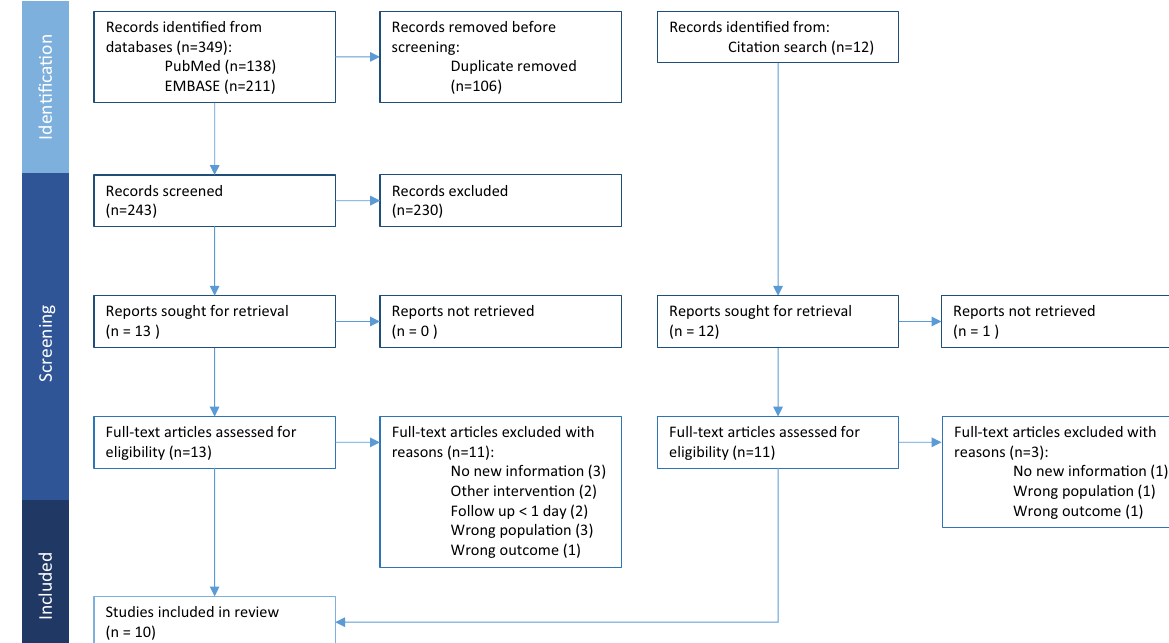
Figure 2. PRISMA Flow Chart. Preferred Reporting Items for Systematic Review and Meta-Analysis (PRISMA) flow diagram showing the identification, screening, eligibility and inclusion process.